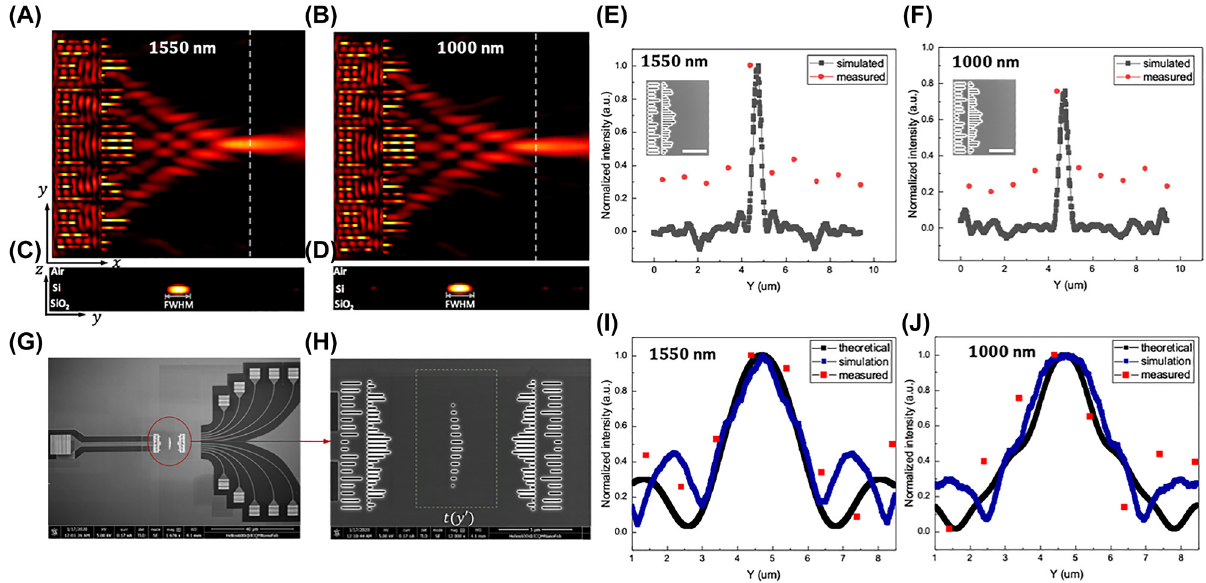
| 2 , in plane ( x–y plane) light distribution of the proposed dispersionless Figure 4: Broadband metasurface convolver [59]. (A) and (B) | E y metalens at wavelength of 1550 and 1000 nm, respectively. The white dotted line shows the focal plane. (C) and (D) Cross-section ( y–z plane) view of light distribution at the focal plane with wavelength of 1550 and 1000 nm, respectively. (E) and (F) Measured light intensity distribution on focal plane along the y -direction compared with simulation results at the dual wavelengths, respectively. Inset: the scanning electron microscope (SEM) image of the characteristic structure of the dispersionless metalens. The scale bar here is 3 μ m. (G) The overall view of SEM image of the proposed convolver. (H) The characteristic structure of the nanophotonic convolver. The area enclosed by the middle dashed box is the given structure with its transmission function t ( y ′ ). (I) and (J) Measured spatial convolution results along the y -direction compared with simulation and theoretical results at the two wavelengths, respectively. The figures are reproduced with permission. Ref. [59] © 2020, The